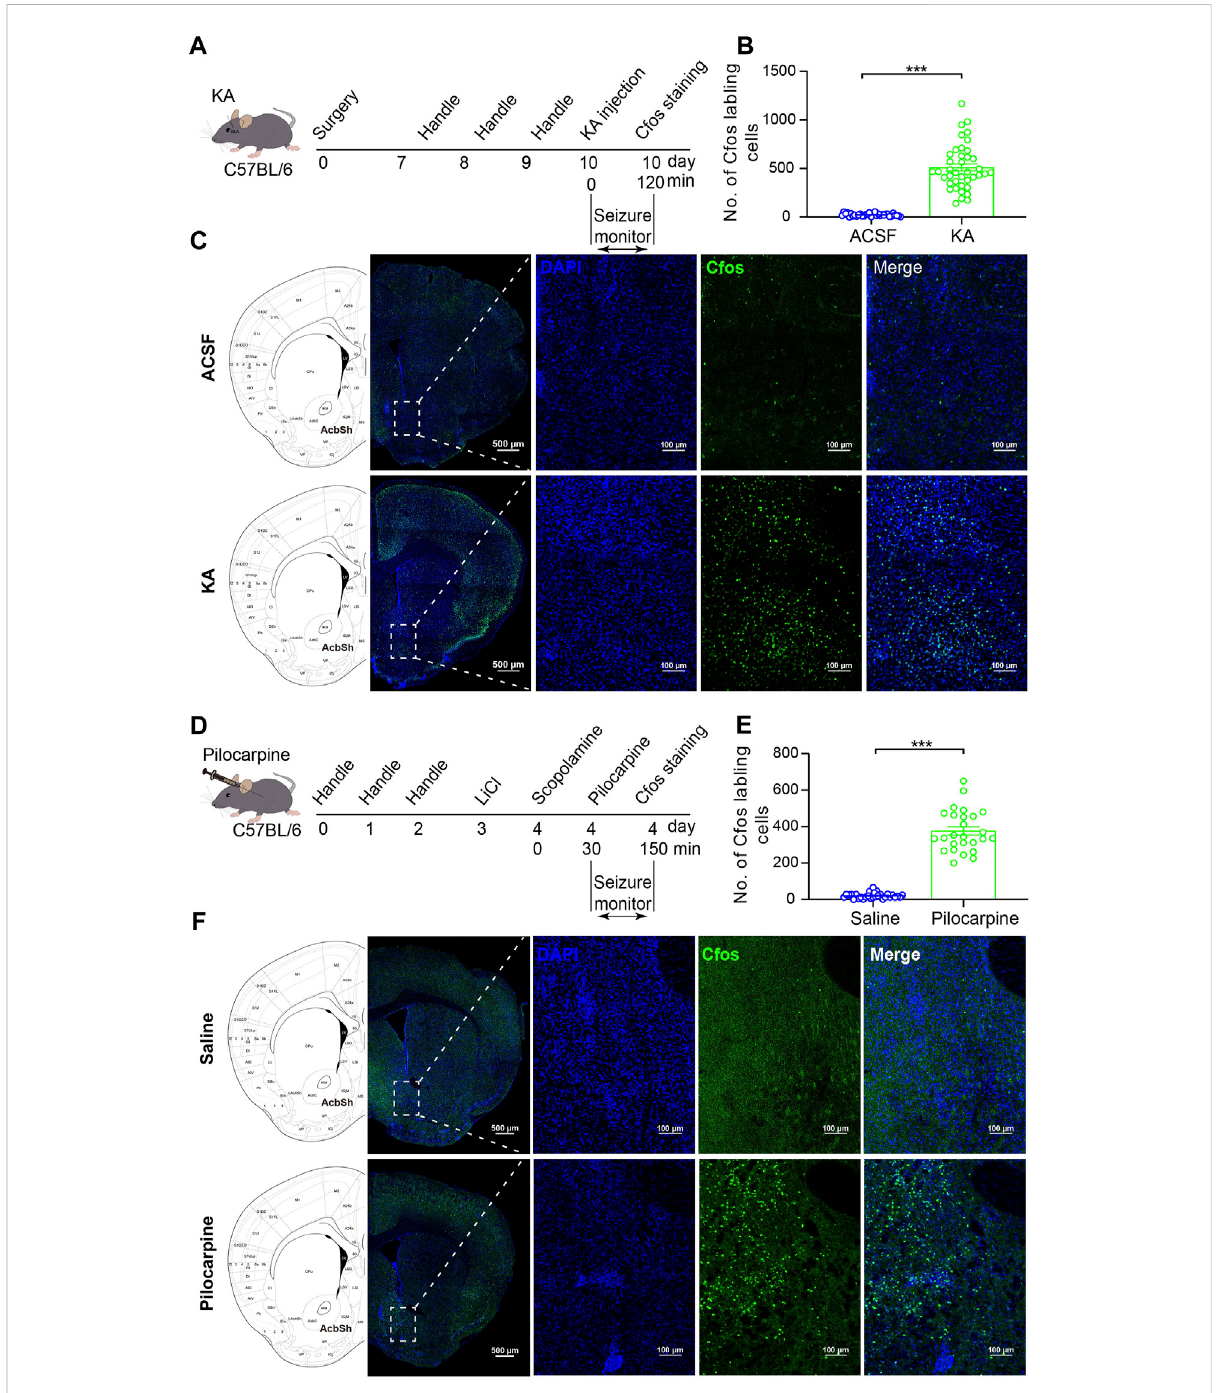
C-fos expression in the NAc shell cells after TLE seizures. (A) Schematic diagram of TLE seizure induction on the C57BL/6 mouse by intra- basolateral amygdala (intra-amygdala) microinjection of KA. (B) Quanti fi cation of the c-fos expression in the NAc shell after seizures of the intra- amygdalaKA modelofTLE. ACSFgroup: n =33slices fromfour mice;KA group: n =40slices fromfour mice;*** p < 0.001, Student ’ sunpairedttest. (C) Representative confocal images showing the c-fos expression in the NAc shell after seizures of the intra-amygdala KA model of TLE. (D) Schematic diagram of mouse TLE seizure induction by i.p. Injection of LiCl – pilocarpine. (E) Quanti fi cation of the c-fos expression in the NAc shell afterseizuresofthesystematicpilocarpinemodelofTLE.Salinegroup: n